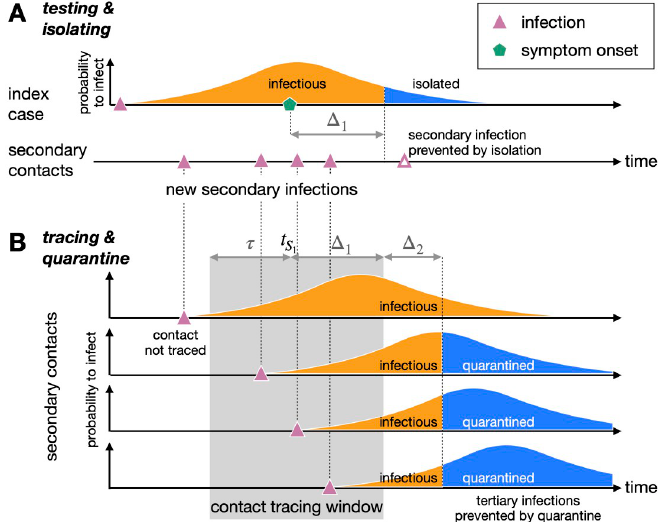
Fig 1. Quantifying the impact of TTIQ interventions using a mathematical model. A: Under testing & isolation, index cases are identified and isolated from the population after a delay Δ 1 after they develop symptoms (at time t ). S 1 This curtails their duration of infectiousness and reduces the number of secondary infections. This isolation occurs in a fraction f of symptomatic individuals. B: Under additional contact tracing & quarantine, the contacts of an index case can be identified and quarantined after an additional delay Δ 2 . This reduces the onward transmission from these secondary contacts. Only contacts that occur during the contact tracing window can be identified. This window extends from τ days before the index case developed symptoms (i.e. t (cid:0) t ) to the time at which the index case S 1